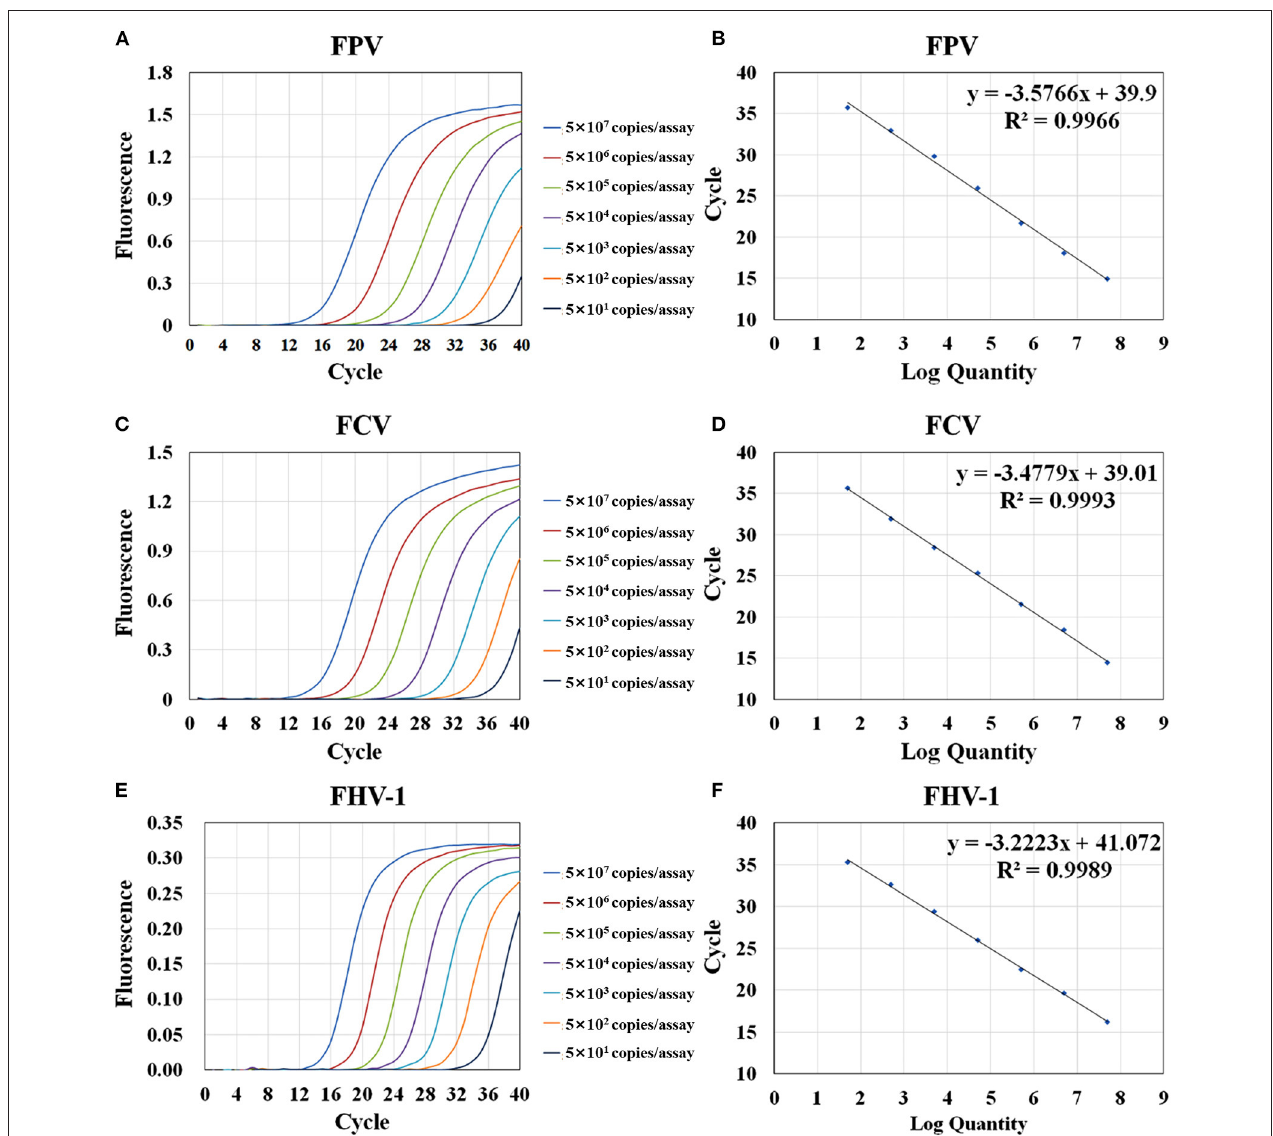
FIGURE 4 | Amplification and standard curves of the triplex assay. Serially diluted plasmids were mixed at equal concentration (from 5 × 10 7 copies/assay to 5 × 10 1 copies/assay) and used as template for RT-PCR. Amplification curves of the triplex assay for the detection of FPV (A) , FCV (C) , and FHV-1 (E) . The standard curves of FPV (B) , FCV (D) , and FHV-1 (F) were generated by plotting the Ct values (Y-axis) against the logarithm of copy numbers of plasmids